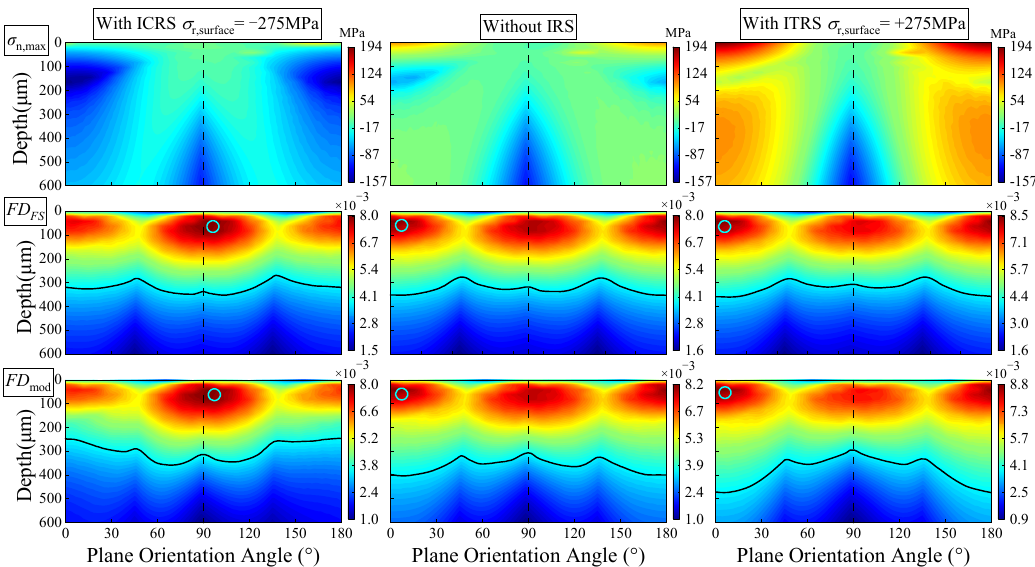
Figure 19. Effect of initial residual stress on σ n ,max and the fatigue damage ( T out = 800 N · m). The variations of FS damage ( FD FS ) and modified FS damage ( FD mod ) are also plotted versus plane orientation in Figure 19, which can provide additional insight into the dam ‐ age mechanisms. Figure 19 shows that the variations of damage value against different plane angles under the modified FS criterion is more obvious than that under the FS cri ‐ terion. The maximum fatigue damage, FD mod,max , occurs at the p = 97° plane with the ICRS case, while the maximum damage, FD mod,max , shifts from p = 97° to p = 5° as the initial residual stress changes from compressive stress to tensile stress. This might be attributed to the fact that the increase of maximum normal stress leads to the increase of the damage near the p = 0° (180°) plane. Therefore, the initial residual stress affects the position of FD mod,max by influencing the distribution of the maximum normal stress under the FS cri ‐